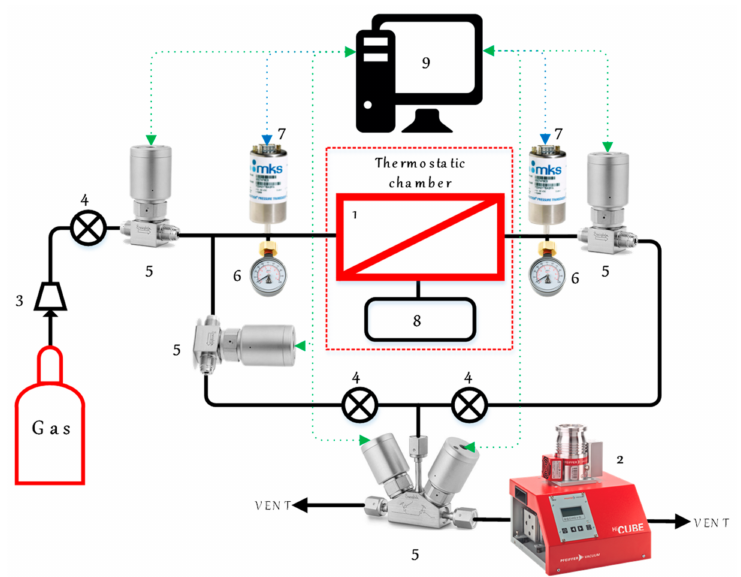
Figure 1. Schematic of experimental setup for single gas permeability test: 1—permeation cell; 2—vacuum station; 3—pressure reducer; 4—manual valves; 5—pneumatic valves; 6—pressure gauges; 7—pressure transducers; 8—additional volume for the permeate side;